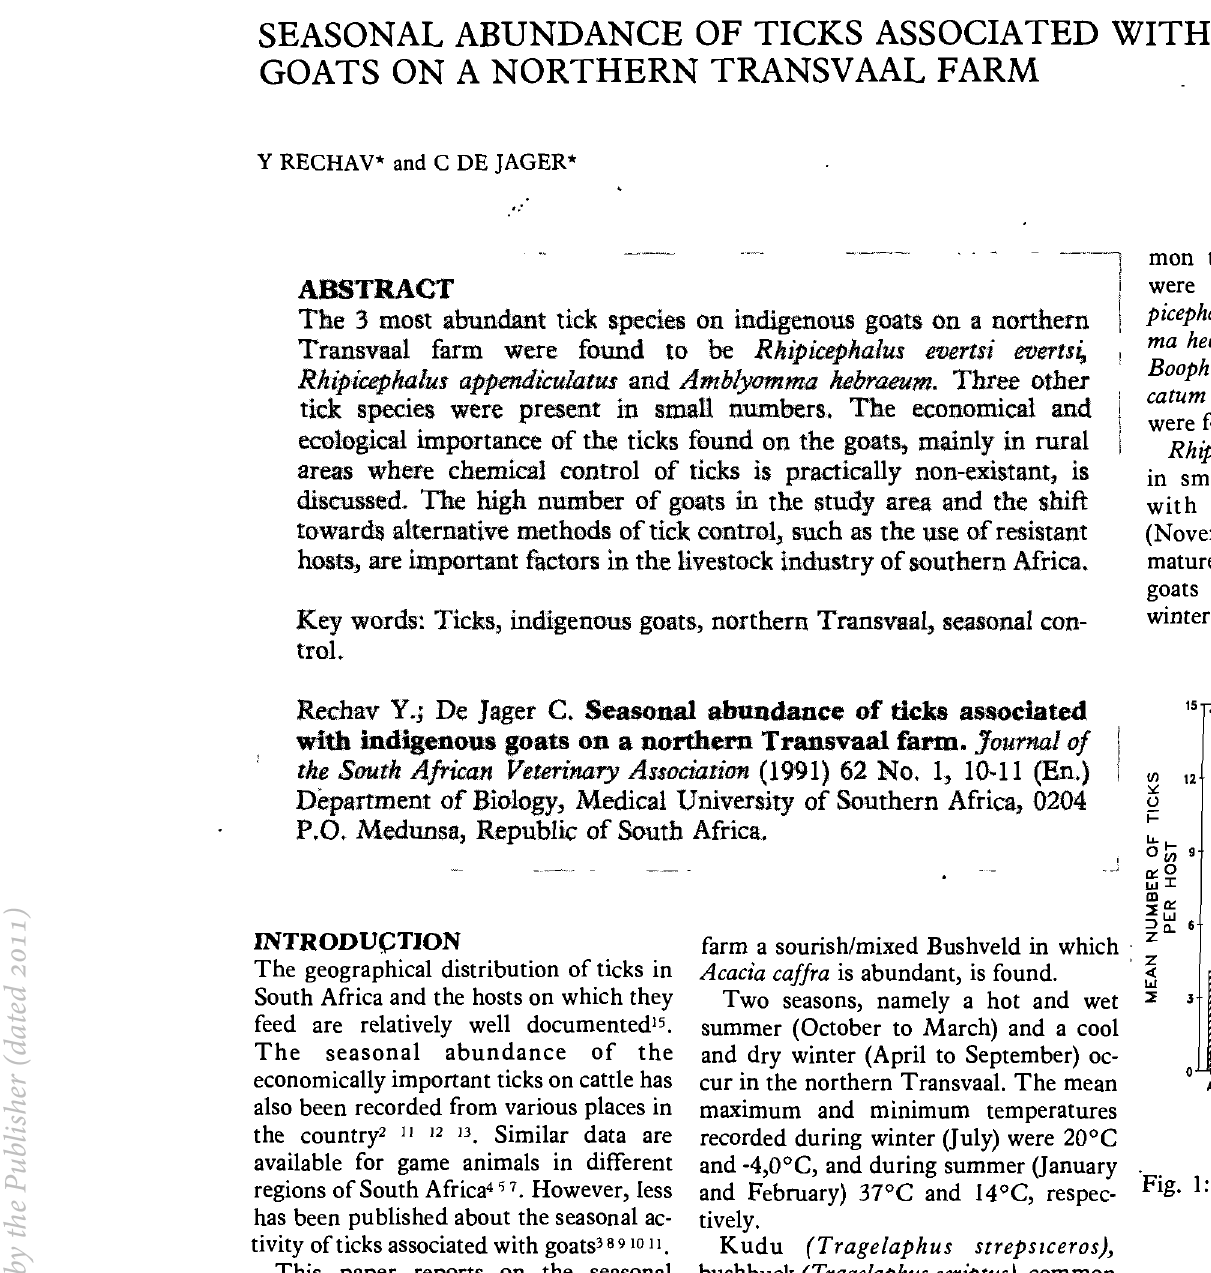
'Fig. 1: Mean number of R.e. everts; adults collected at